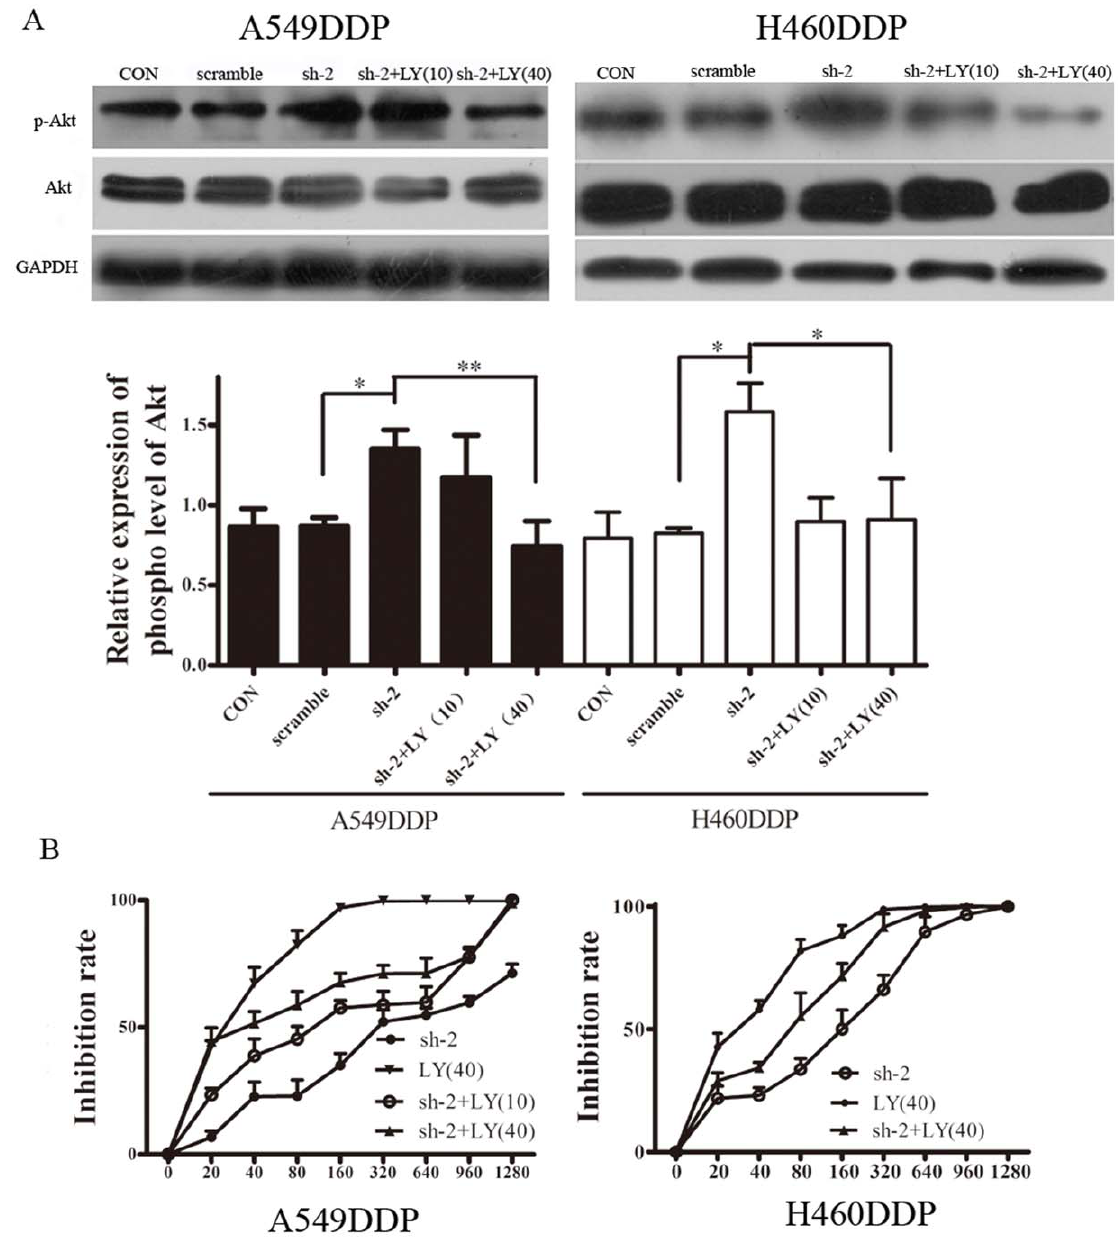
Figure 4. Inhibition of PI3K/Akt signal pathway increased chemotherapeutic sensitivity and promoted apoptosis of shRNA transfected cisplatin resitant cells. A: A549DDP and H460DDP cells transfected with shRNA were treated with LY294002 (10 and 40 m M). Western blot assay demonstrated that LY294002 could significantly lower the p-Akt expression, especially after treatment with 40 m M LY294002. B: Cells transfected with shRNA were treated with LY294002 at different concentrations, and MTT assay was performed to measure the IC50. C: Apoptosis related proteins, Bax and bcl-2, were detected. Results showed klotho over-expression could increase the Bax/bcl-2 ratio while the klotho knockdown decreased it. LY294002 could reverse the decreased ratio following shRNA transfection. GAPDH served as an internal reference. Experiments were performed in triplicate and data presented as mean 6 SD (* P , 0.05, ** P , 0.01).